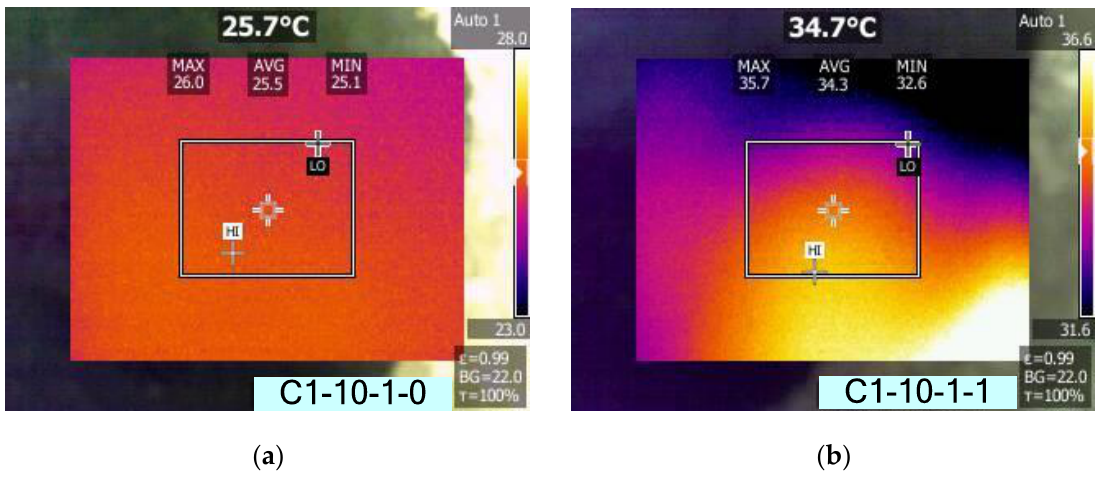
Figure 17. Spectrogram of coal samples with size of S1 before and after microwave irradiation of 10 s. ( a ) Before microwave irradiation; ( b ) After microwave irradiation.